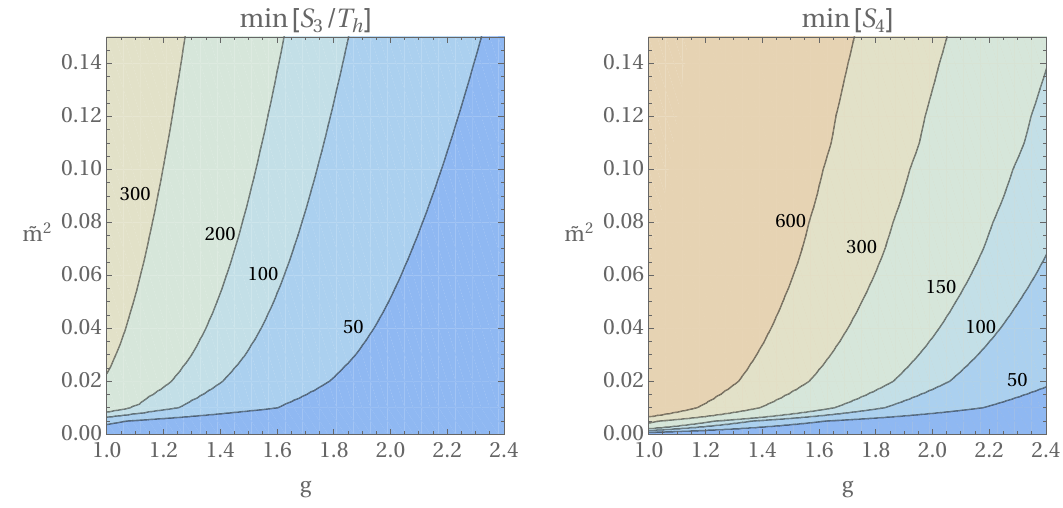
Figure 3 . Contours of the minimum values of S 3 /T h (left) and S 4 (right) as a function of the parameters of the hidden sector (defined in section